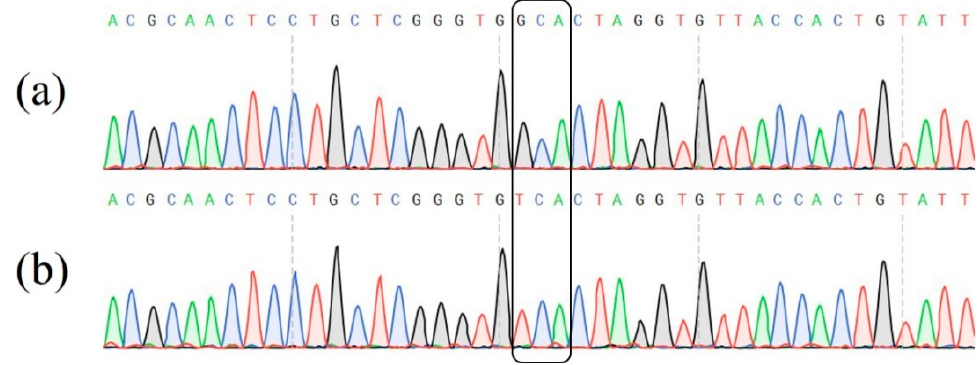
Figure 1. Schematic representation of LAMP primers. F1c and B1c were complementary to F1 and B1.